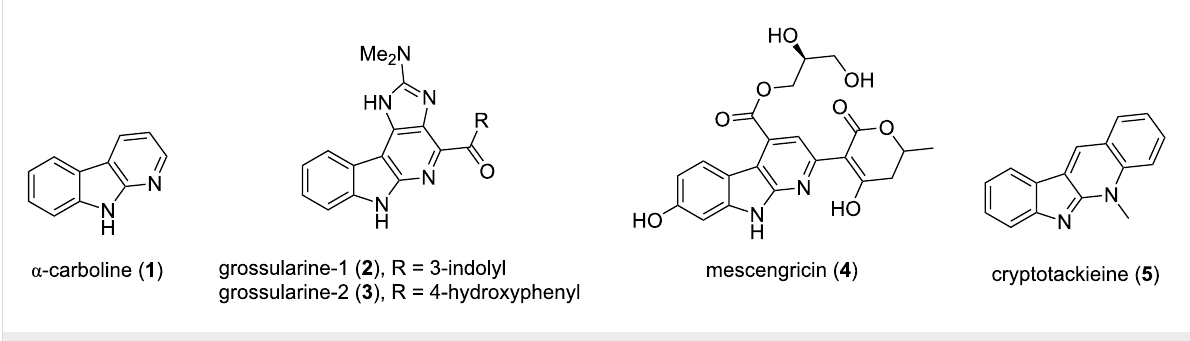
Figure 1: Natural products with α -carboline subunits.